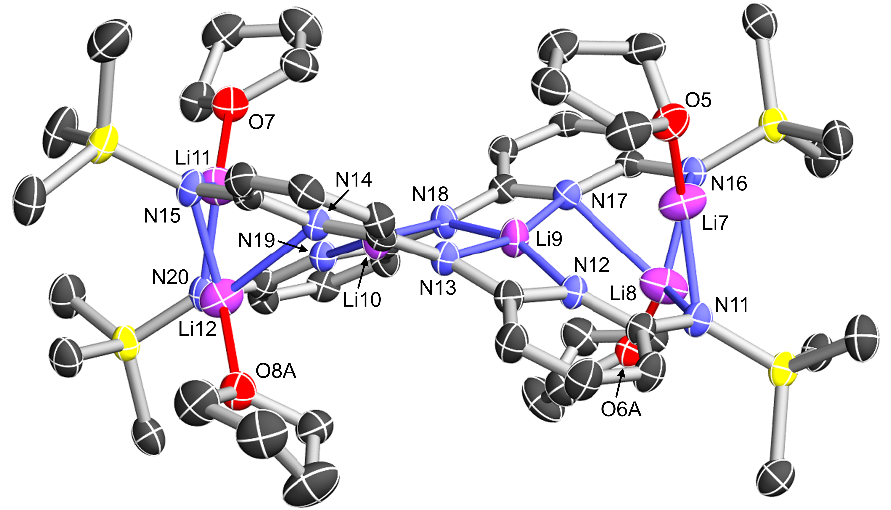
Figure 5. Molecular structure of mol2 in 2 , viewed approximately along the line joining N13 and N18. Same color code as in Figure 3. Thermal ellipsoids are at 60% probability level. Hydrogen atoms and the minority components of the disordered thf molecules bound to Li8 and Li12 are omitted for clarity.